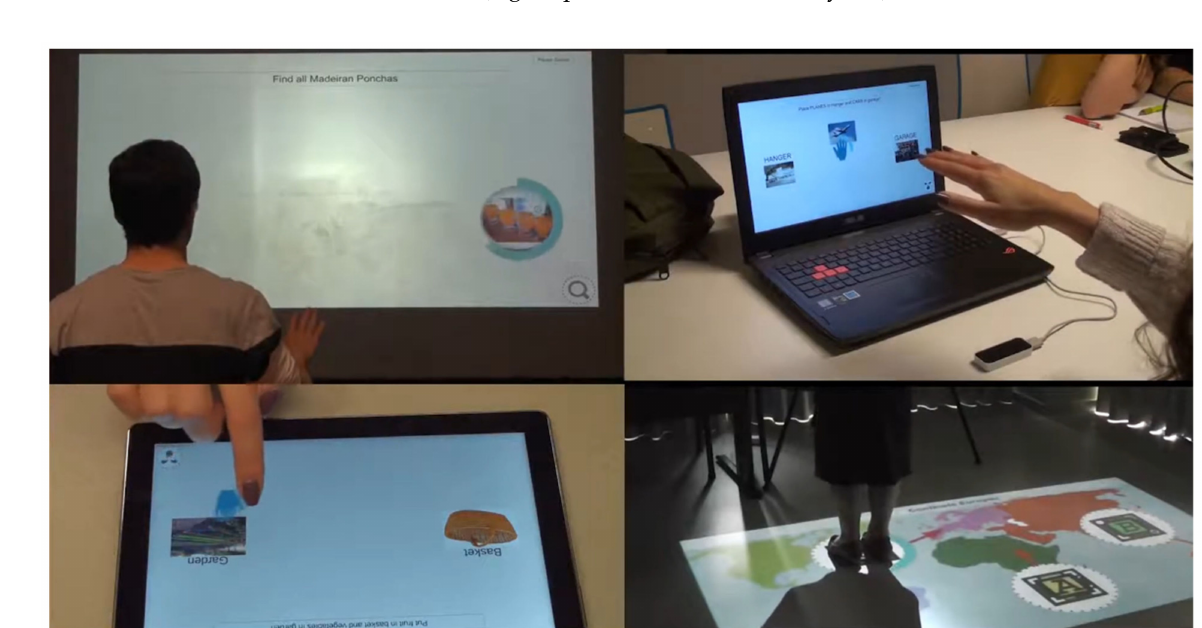
Figure 1. Examples of Musiquence activities being performed in several types of